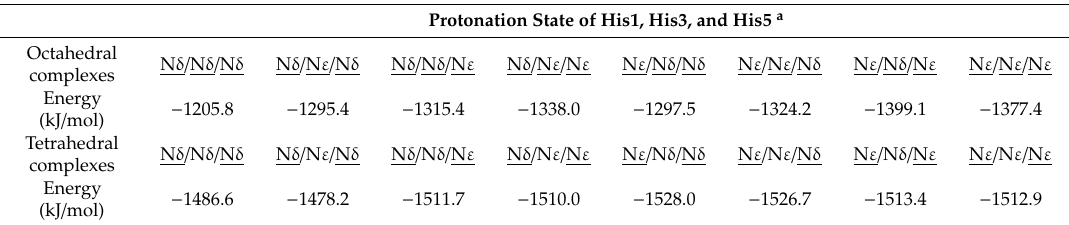
Table 3. Energy values of the Monte Carlo minimized models of the (dH3w) 2 Zn(II) complex. Protonation State of His1, His3, and His5